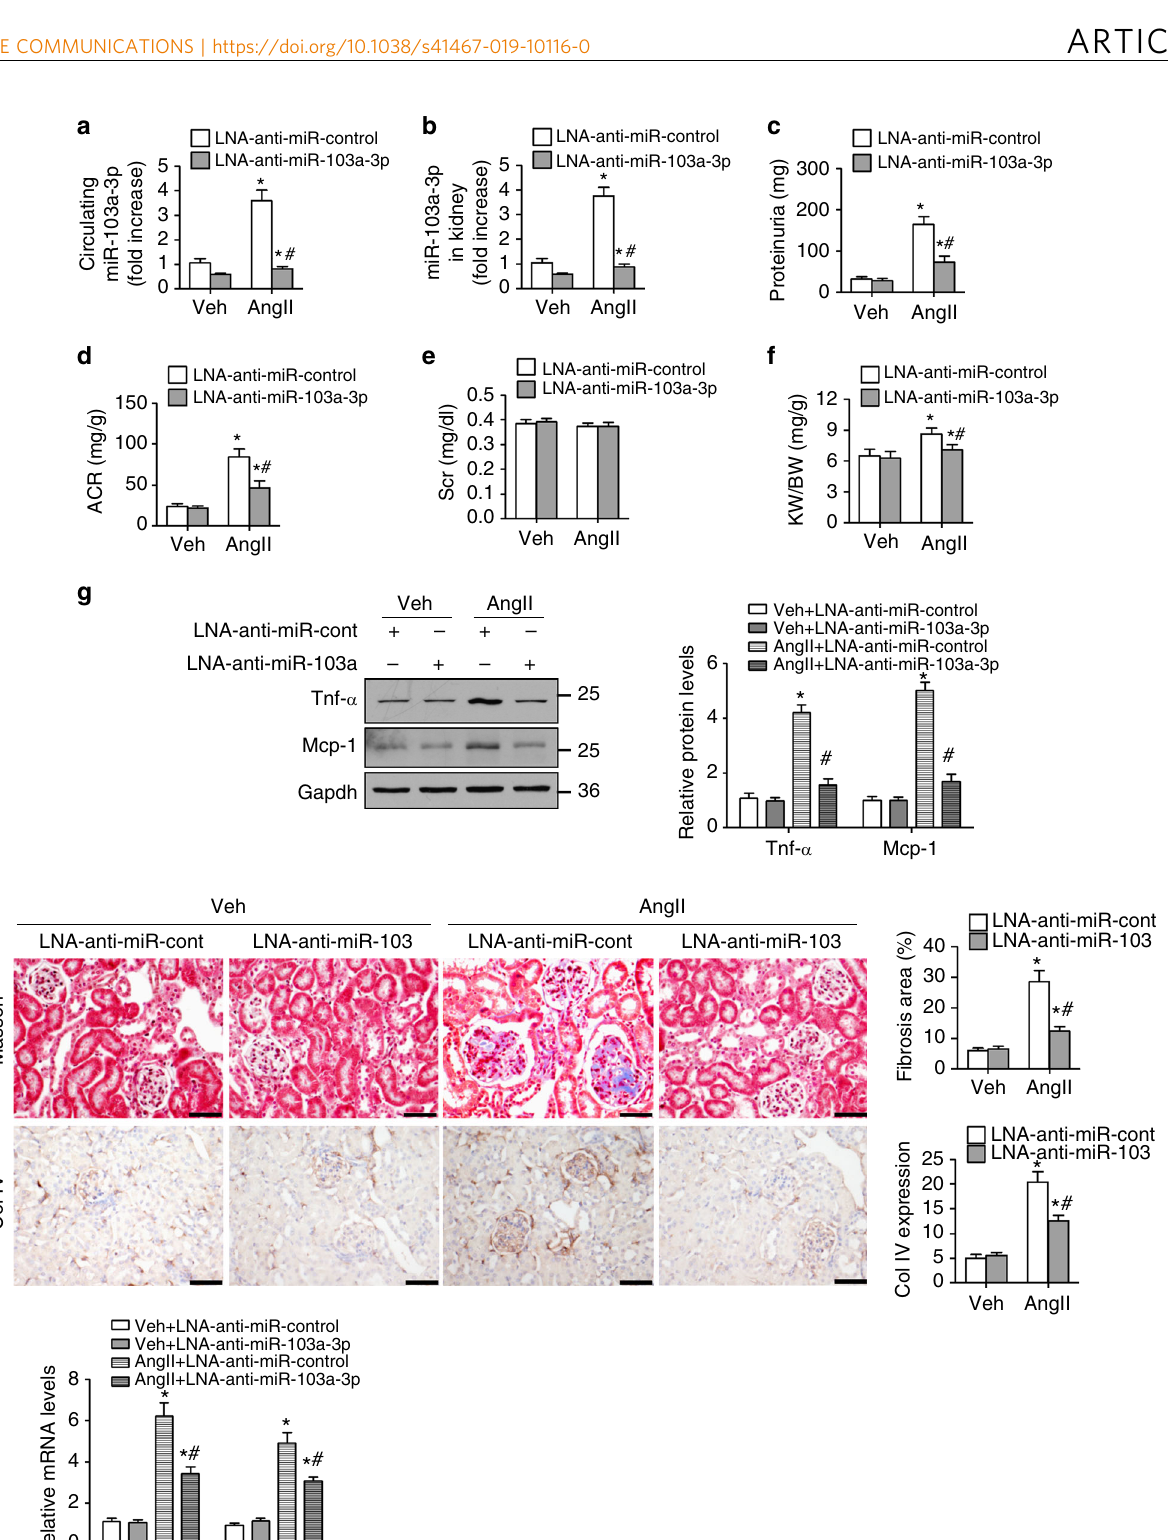
Fig. 3 Reduction of miR-103a-3p ameliorates AngII ‐ induced renal injury. Mice ( n = 8 per group) injected with LNA-anti-miR-103a-3p or LNA-anti-miR- control were infused with a vehicle control (Veh) or AngII (1 mg kg − 1 d − 1 ) for 4 weeks. a Serum miR-103a-3p levels were analyzed by qRT-PCR. b Kidney tissue miR-103a-3p levels. c Albumin excretion rate. d Albumin/creatinine ratio (ACR). e Serum creatinine levels. f Kidney weight to body weight ratio (KW/BW). g Western blot analysis of Mcp-1 and Tnf- α expression in the kidneys. h Representative images of trichrome staining and immunohistochemical staining of collagen type IV (Col IV) in the kidneys (scale bar = 50 µ m). i Collagen type I and IV mRNA levels were measured using qRT-PCR. For all experiments, n = 8 per group; * p < 0.05 relative to vehicle control; # p < 0.05 relative to LNA-anti-miR-Control. Statistical analysis was carried out by a Student ’ s two-tailed t -test. The corresponding source data are available in the Source Data fi